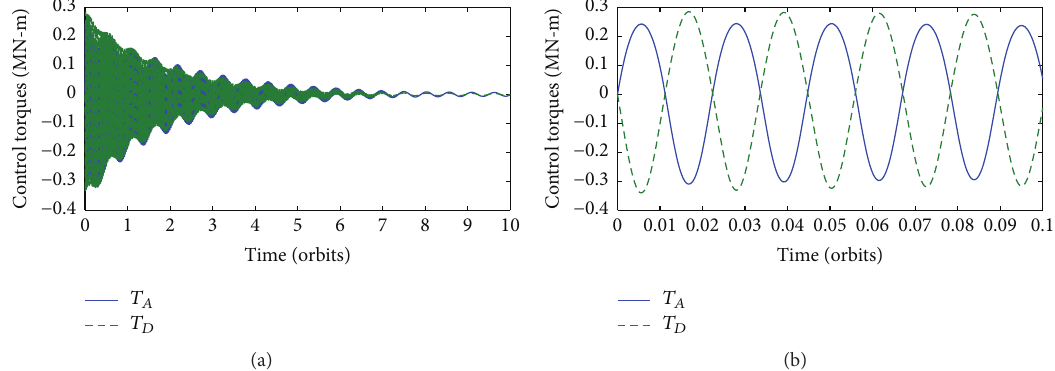
Figure 19: Control torques from the formulations based on point 𝐴 by applying the SDRE control with 𝛼 = 10 −6 for (a) the first 10 orbits and (b) the first 0.1